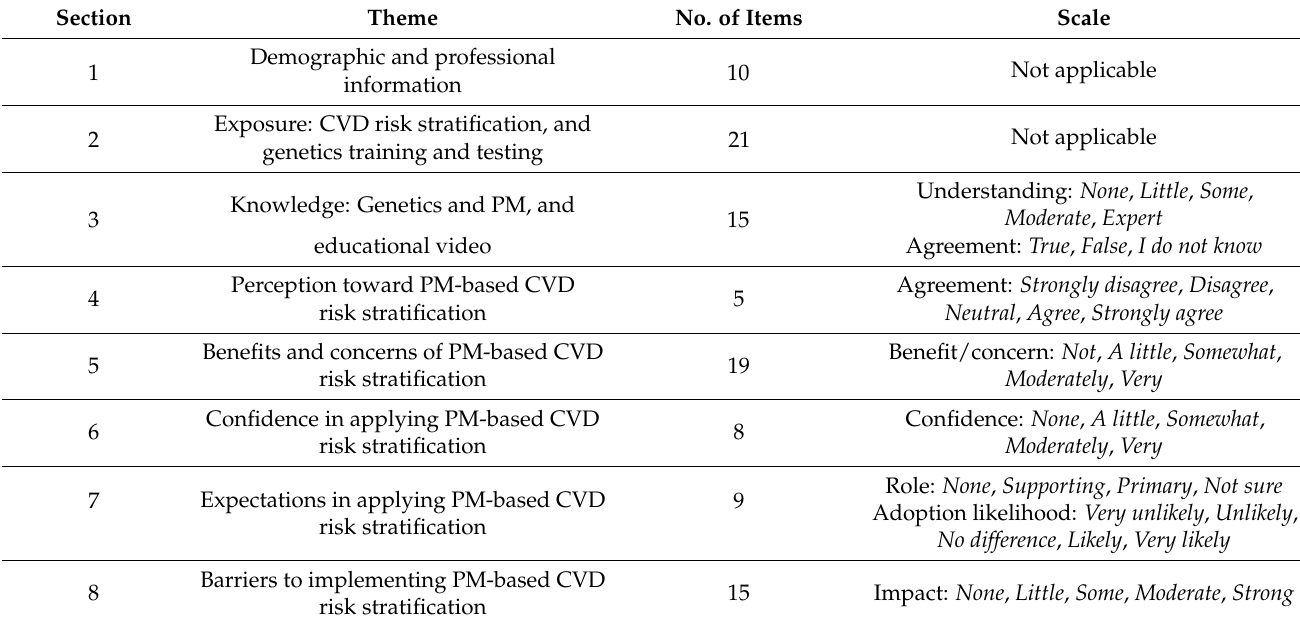
Table 1. Survey organization and associated scales